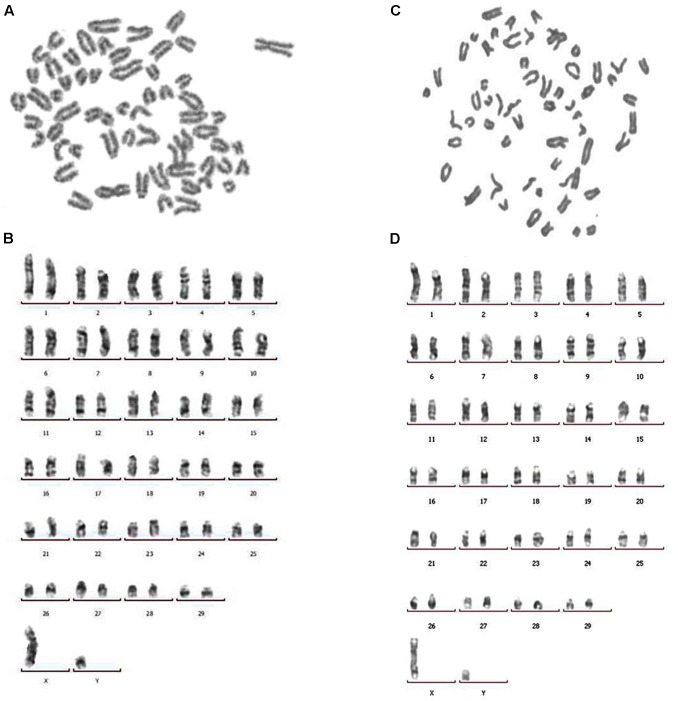
Chromosomal analysis of primary BTY cells and the hTERT-BTY cell line. (A) Chromosomes of primary BTY cells with a diploid number of 60. (B) GTG-banded primary BTY cell karyotype. (C) Chromosomes of hTERT-BTY cell line with a diploid number of 60. (D) GTG-banded hTERT-BTY cell line karyotype.